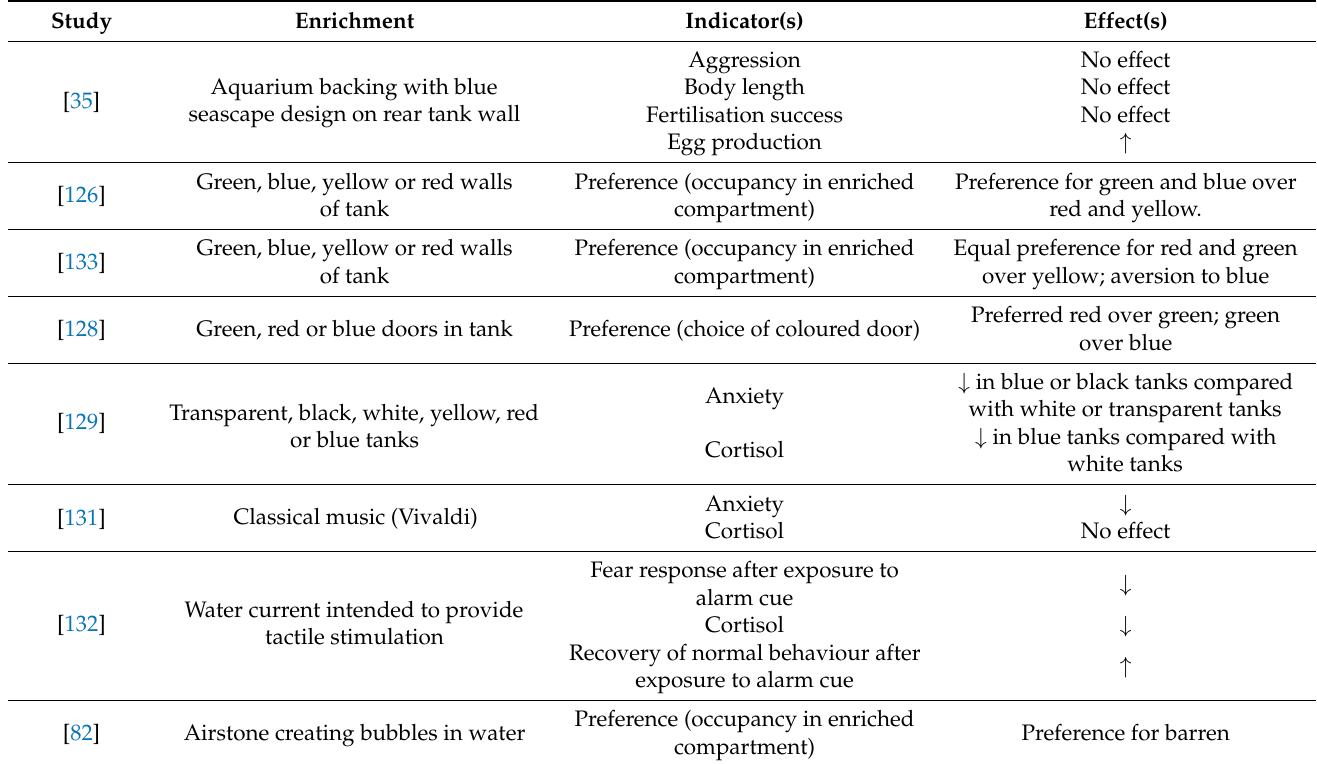
Table 4. Key results of studies relating to sensory enrichment for laboratory zebrafish. Studies have been included where they have either addressed a preference (such as might be used to identify conditions which might promote welfare), or tested the effects of a condition intended to provide enrichment. Unless otherwise specified, all results here relate to the presence of the enrichment condition noted in the table compared with an absence of that